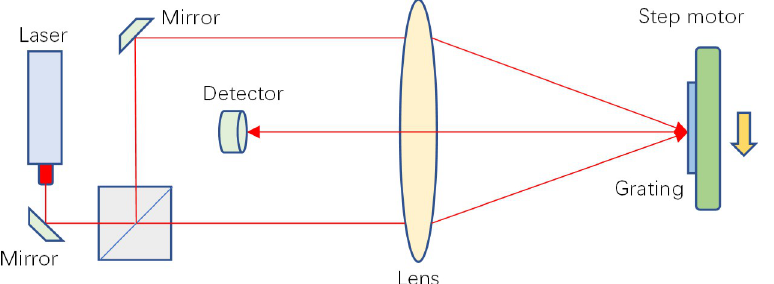
Fig 2. Scheme of the experimental